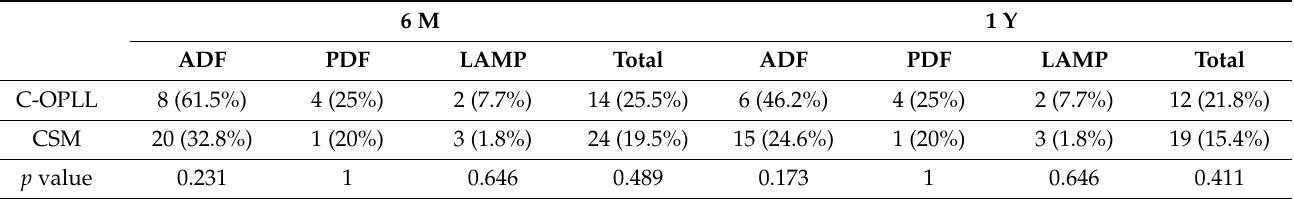
Table 5. New dysphagia.